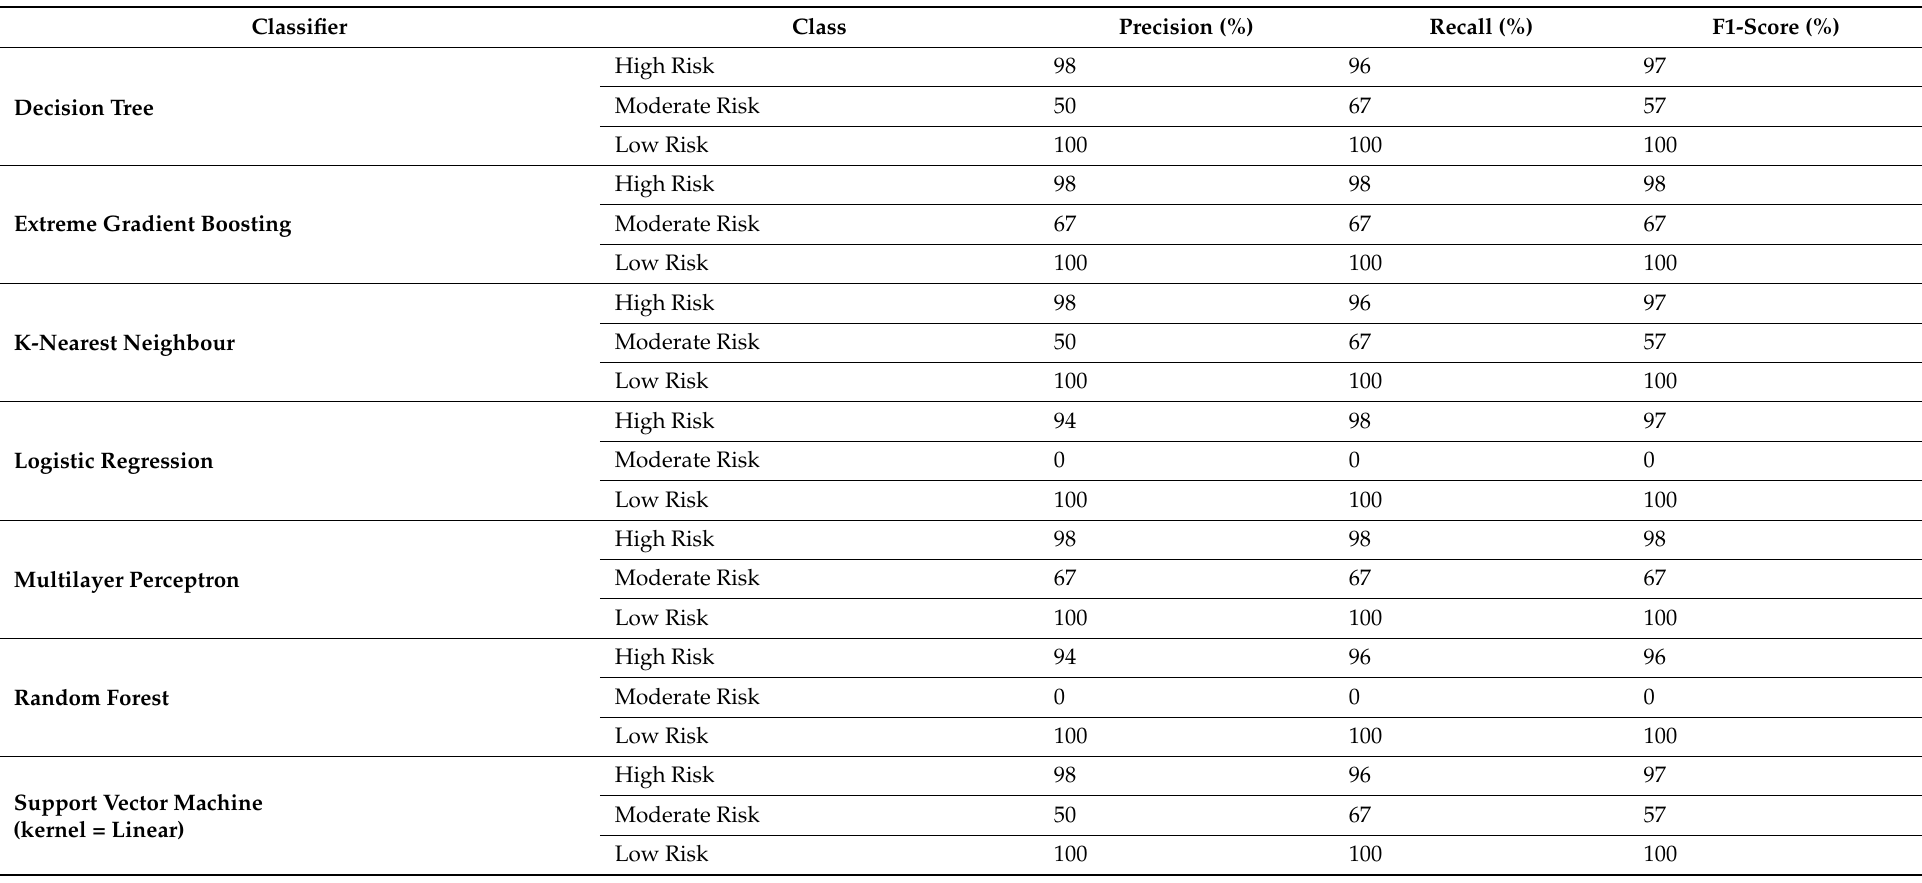
Table 2. Classifiers in detail in terms of precision, recall, and F1-score for 3 different types of